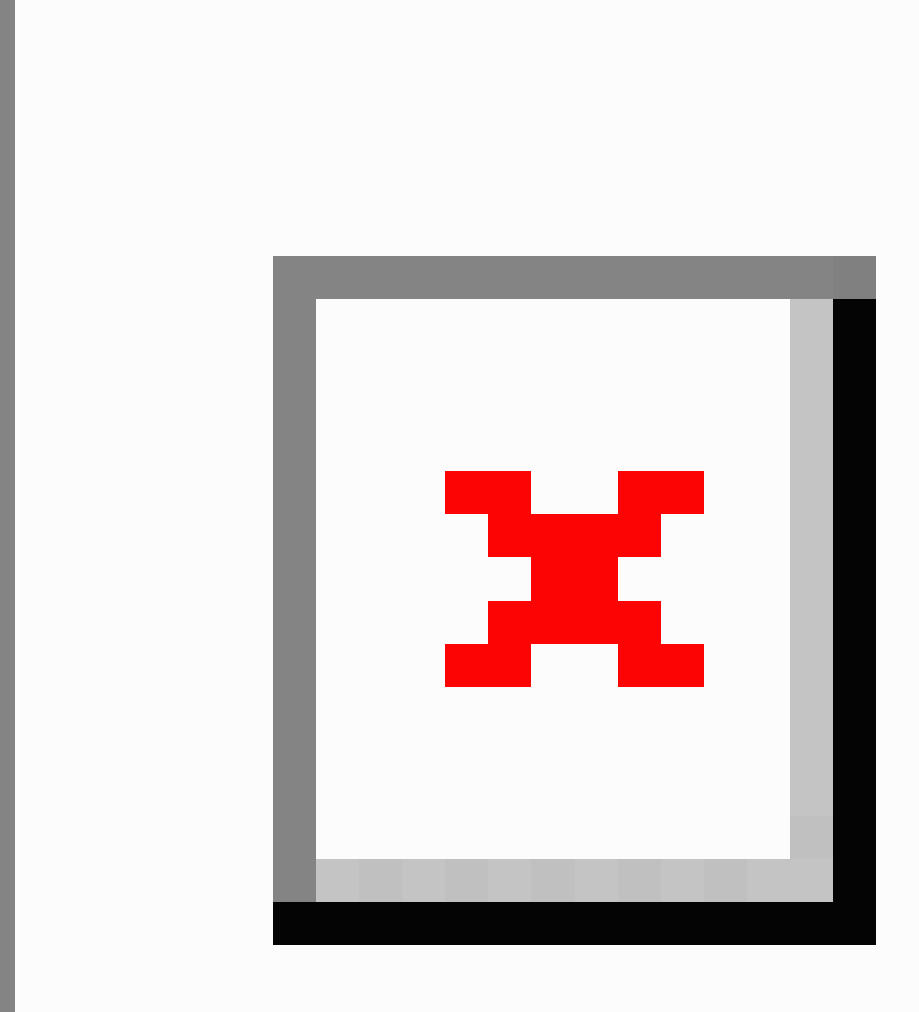
Figure 2. Success rates for task completion